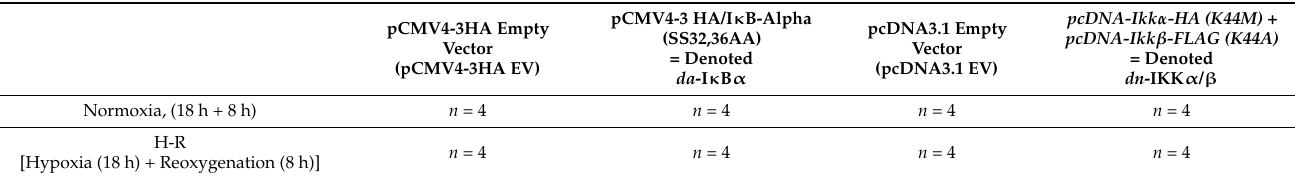
Table 1. Experimental paradigm and experimental